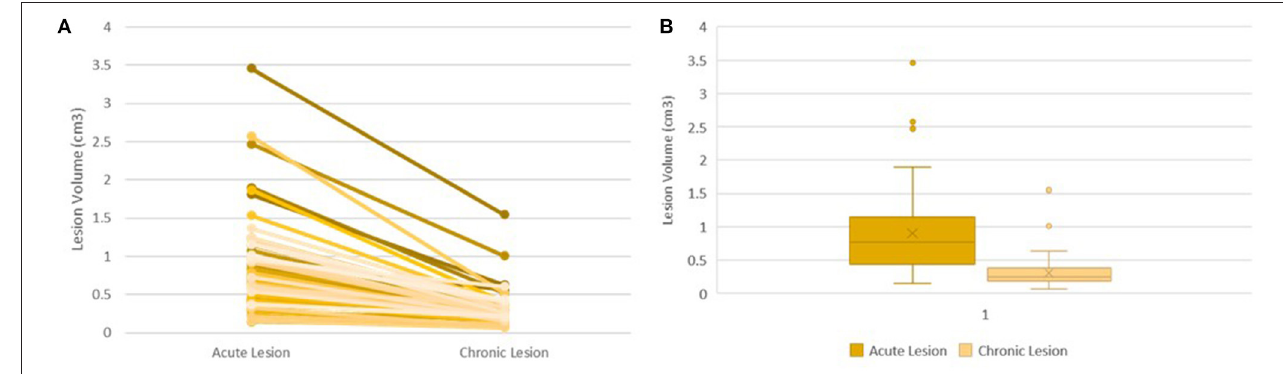
FIGURE 1 | Lesion Volume Evolution Following Ablation. Trend of Lesion Volume Evolution between the Acute and Chronic Phase in all 55 lesions (A) . Box Plot Showing Distribution of Acute Volumes and Chronic Volumes (B) .